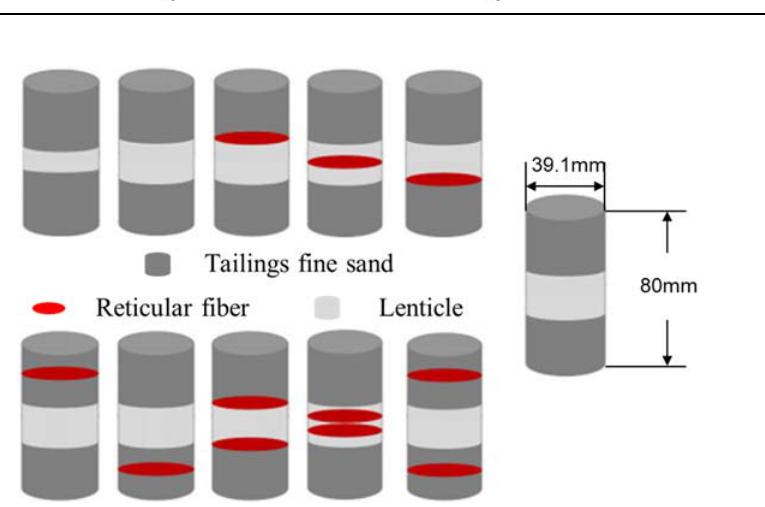
Figure 3. The samples.